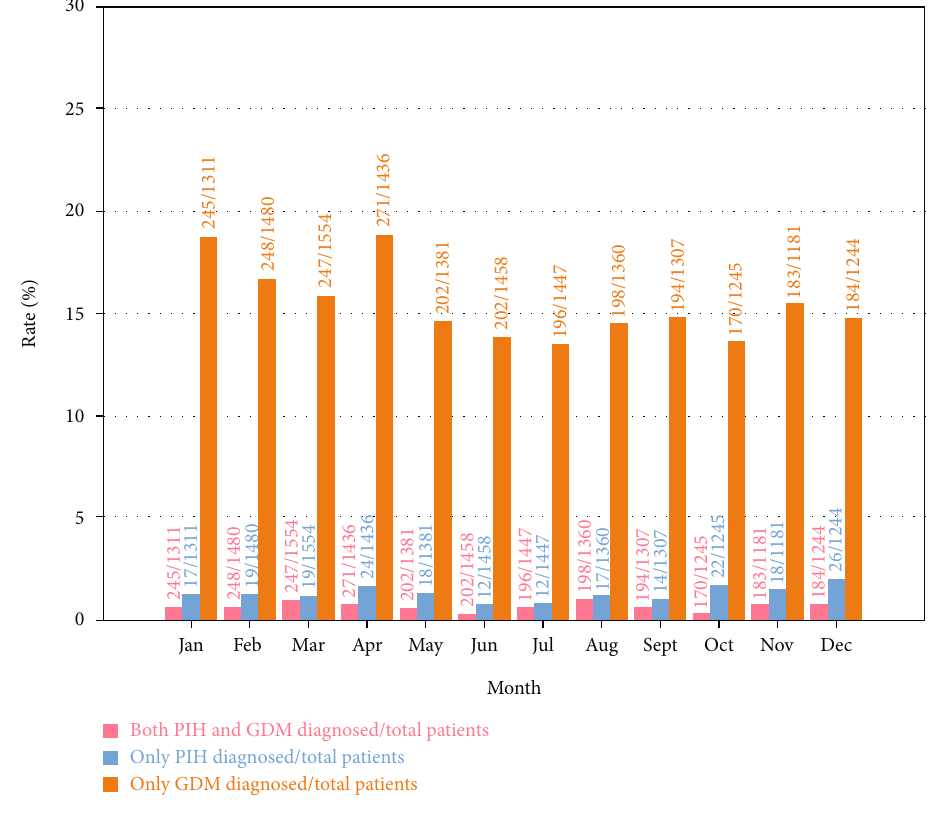
Figure 4: PIH, GDM, and both rate distribution histogram with